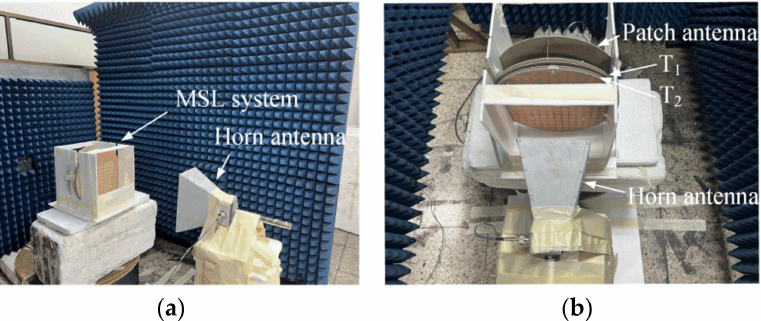
Figure 7. Photographs of measurement setup for the proposed Moir é -inspired MSL system: ( a ) iso- metric view; and ( b ) top